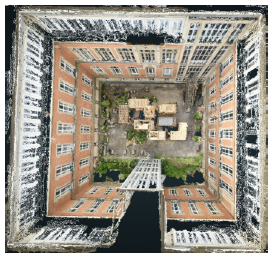
Figure 3. Atrium from above. Notice, the red bricked walls with